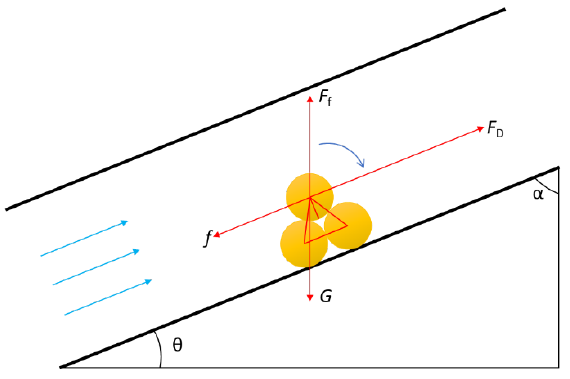
Figure 2. Stress analysis of solid sulfur particle in wellbore.